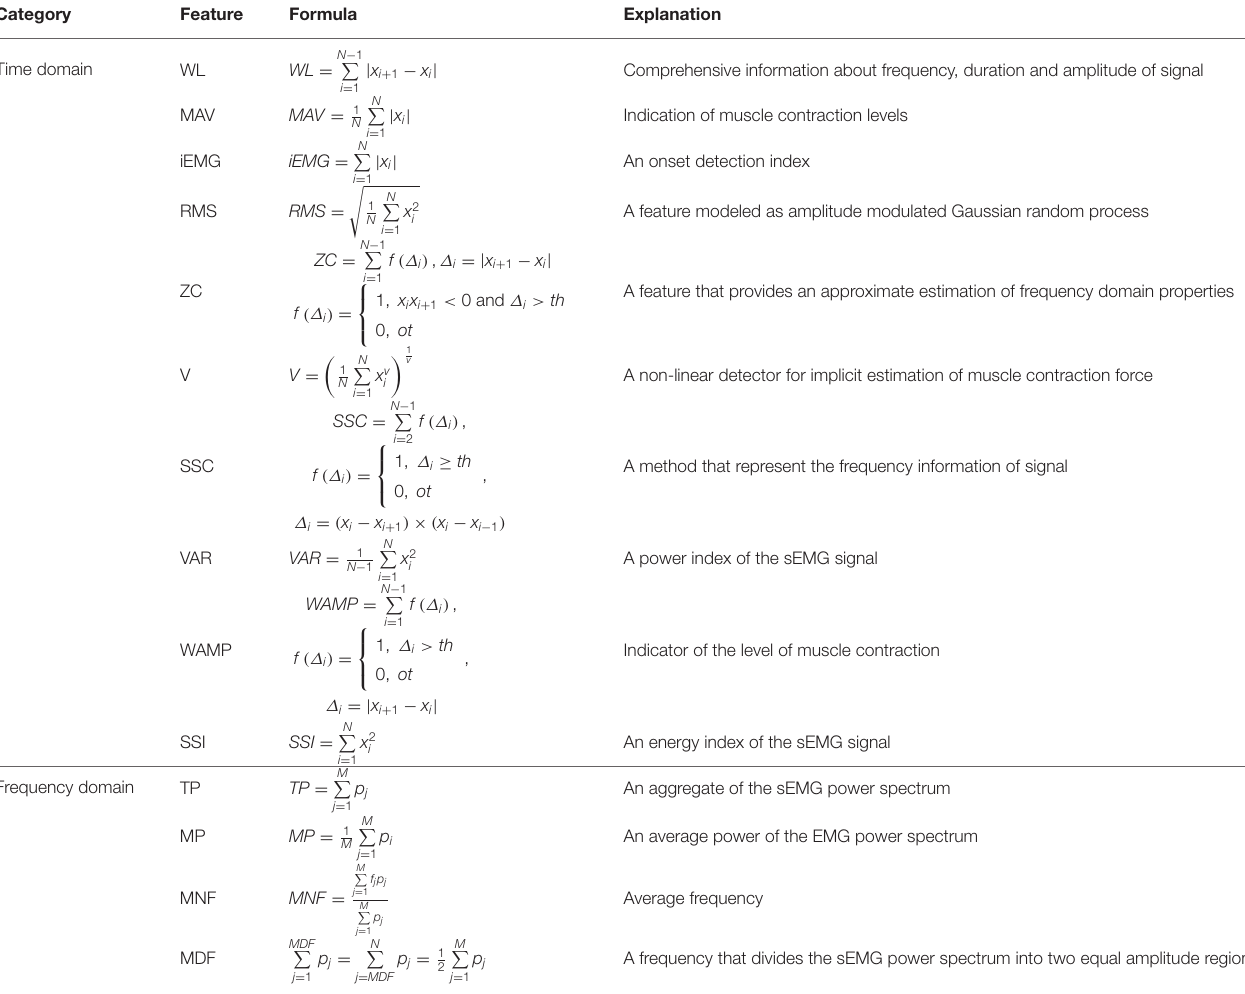
TABLE 1 | Features according to the domain.